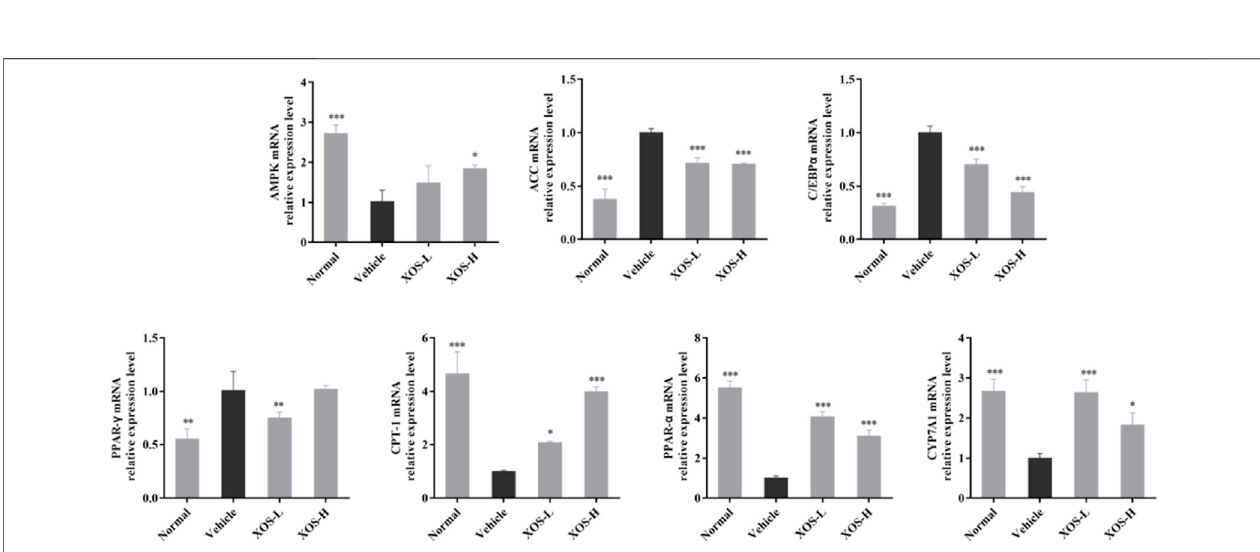
FIGURE7| EffectofXOSsupplementationonAMPK,ACC,C/EBP α ,PPAR- γ ,CPT-1,PPAR- α ,andCYP7A1mRNAexpressioninlivertissueofmice.XOS-L:mice treat with XOS 250 mg/kg, XOS-H: mice treat with XOS 500 mg/kg. * p < 0.05, ** p < 0.01, *** p < 0.001 compared with the Vehicle group.